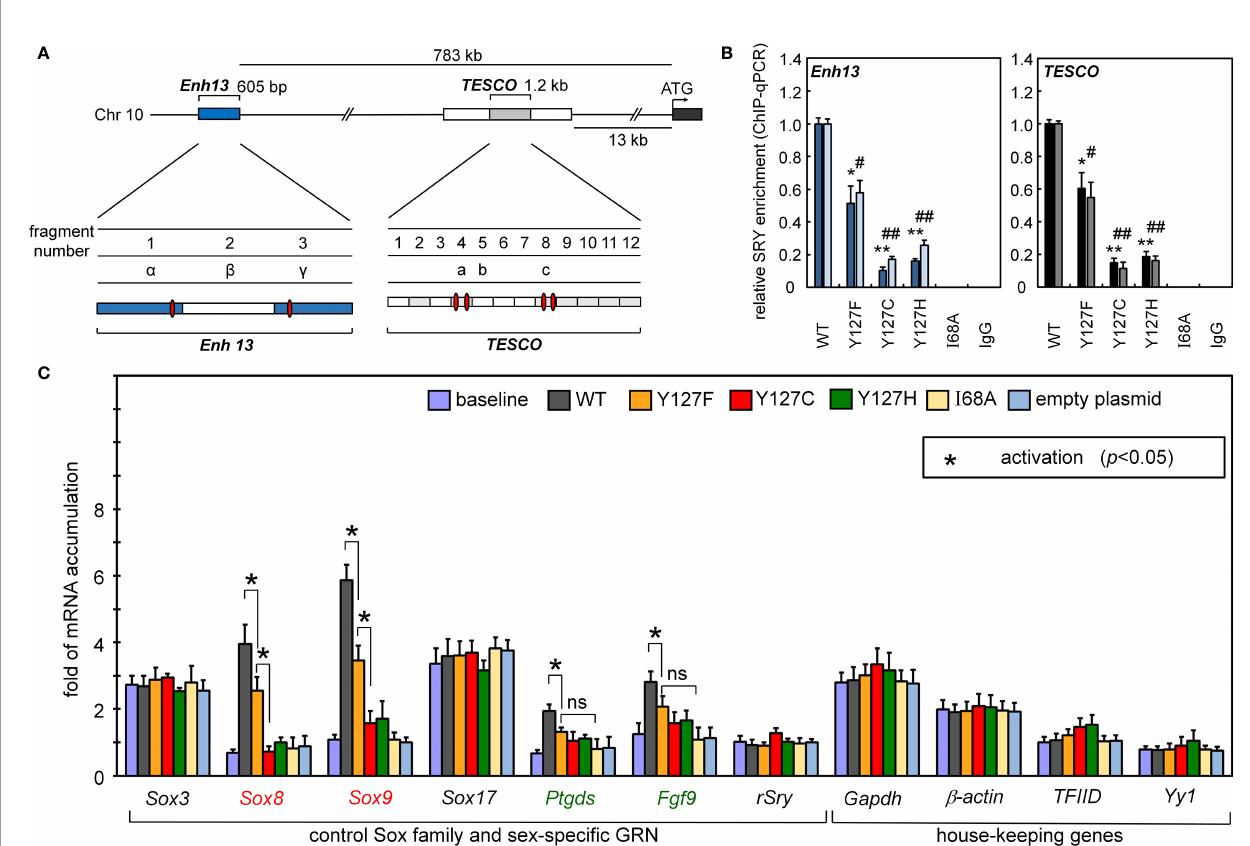
FIGURE 3 | Gene-regulatory activities of SRY variants. (A) During differentiation of the embryonic gonadal ridge, rodent and human Sox9 / SOX9 genes are each regulated by upstream testis-speci fi c enhancer elements: Enh13 (17) (blue) and TESCO (16) (light gray). Potential SRY-binding sites in Enh13 are present in fragments 1 and 3 (related to primer sets a and b ) and in TESCO fragments 4 and 8 (primer sets a and c). (B) Effects of mutations in SRY HMG box on enhancer occupancies. Respective SRY-Enh13 (left) and SRY-TESCO (right) occupancies were probed and quanti fi ed by ChIP-qPCR (16, 17) as indicated by respective histograms. Results were normalized relative to WT SRY (at left in each panel). Respective control lanes I68A indicate an inactive SRY (39); IgG lanes indicate non- speci fi c control (* and #), (** and ##) indicate statistical signi fi cance at respective levels p<0.05 and <0.01. (C) Transcriptional survey of selected genes pertinent to male development (30). Surveyed mRNAs include sex determination speci fi c genes Sox8 , Sox9 , Ptgds , Fgf9 , and original endogenous rat Sry ; controls were provided by housekeeping genes (30). In each case baseline mRNA abundances were determined in non-transfected cells. Inset box, statistical signi fi cance at the level p<0.05 (Wilcox test) for SRY-dependent transcriptional activation